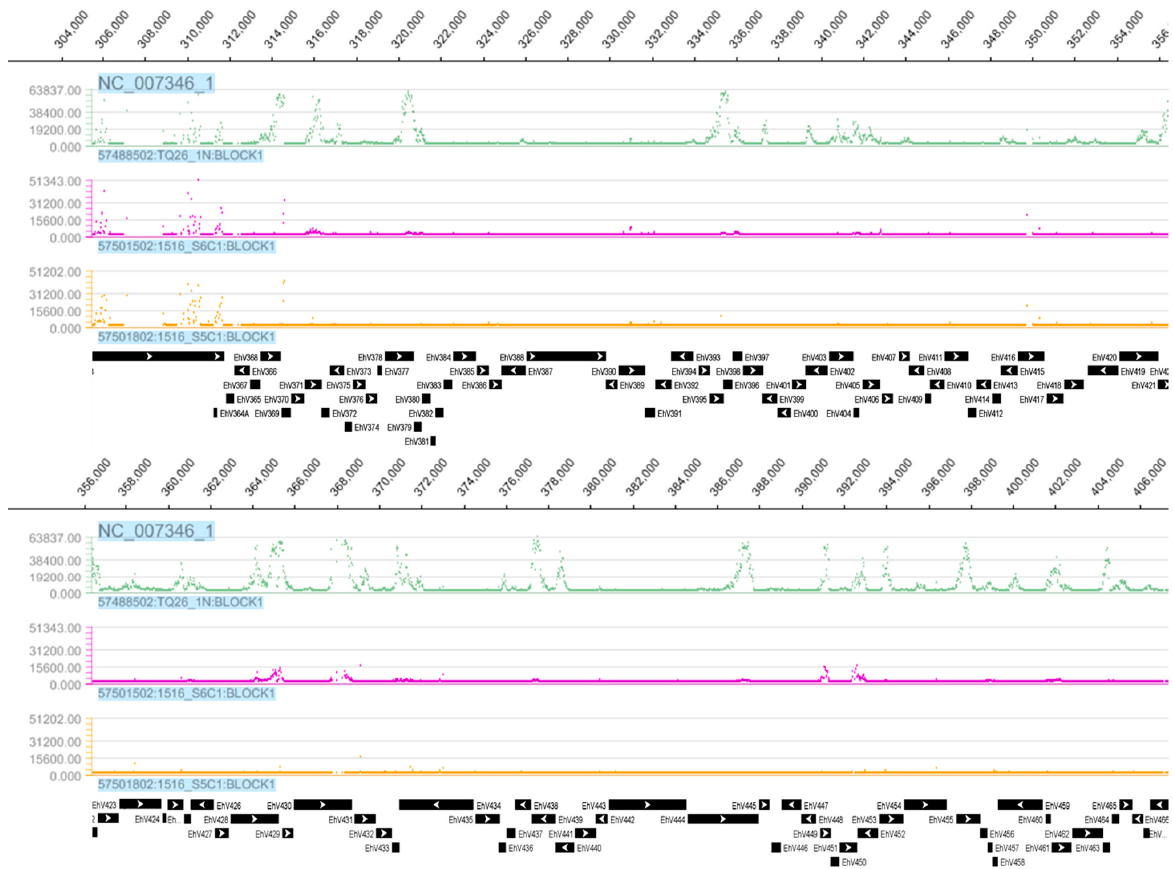
Figure 2. Nimblegen SignalMap displays of fluorescence values from TA for the whole EhV ‐ 86 genome (NC_007346_1) in base pairs with corresponding CDS map created by The National Center for Biotechnology Information (NCBI) [31] shown below each set of genome tracks. The first, second, and third tracks in green, purple, and orange display the expression profiles obtained from RCC1217 (1N) from chip 57288502, CCMP1516 infected with EhV ‐ 86 3.5 h p.i. from chip 57501502, and CCMP1516 infected with EhV ‐ 86 30 min p.i. from chip 57501802 (Table 3), respectively. Individual CDSs are illustrated as solid black rectangles with the internal white arrow head indicating the 5’ to 3’ coding direction.